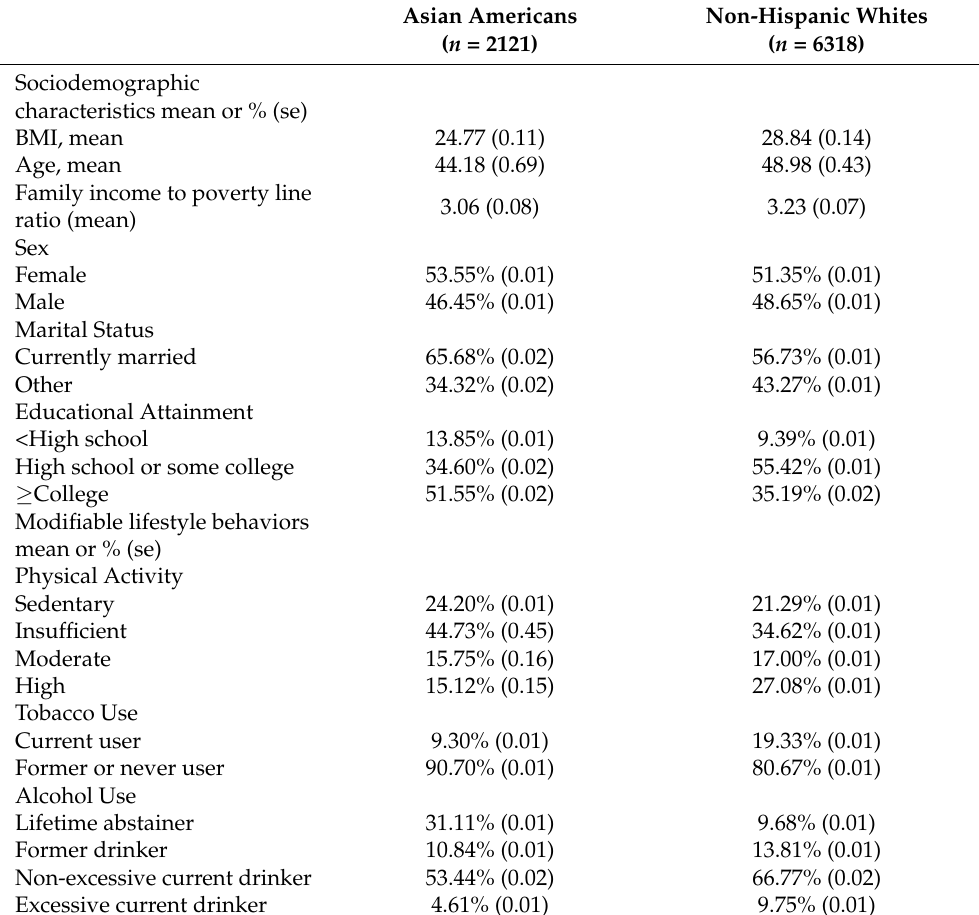
Table 2. Descriptive statistics of BMI, sociodemographic characteristics and modifiable lifestyle behaviors for Asian American and non-Hispanic White samples.